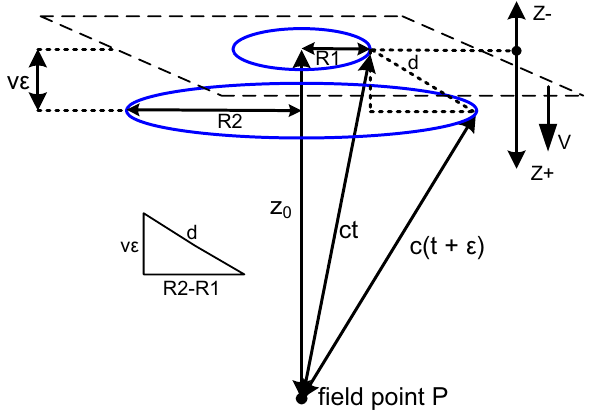
Figure 3. The geometry of an infinite planar impulsive source moving toward P with speed v . (a speed away from P would be given by − v .) R 1 is the radius of the circle created by the intersection at time t of a sphere of radius ct with the plane. R 2 is the radius of the circle created by the intersection at time t + ε of a sphere of radius c [ t + ε ] with the